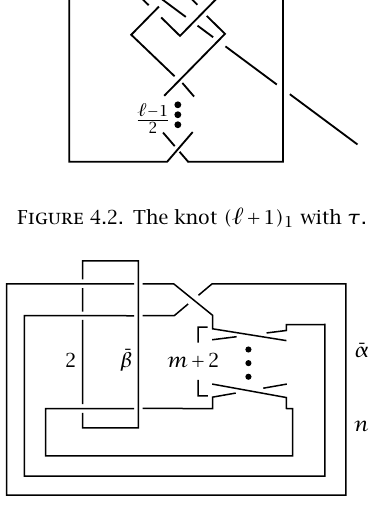
Figure 4.3 . The singular set of ((cid:2) + 1 ) 1 / (cid:4) τ (cid:6)